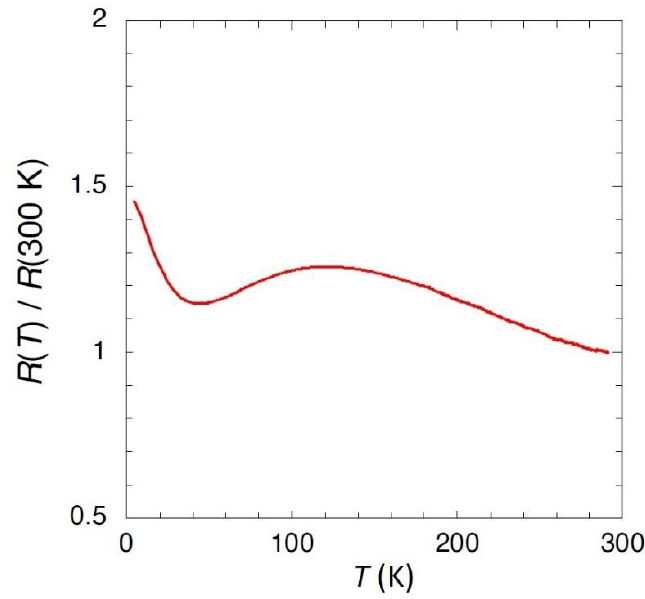
Figure 5. Electrical resistivity for Co-PhBr.